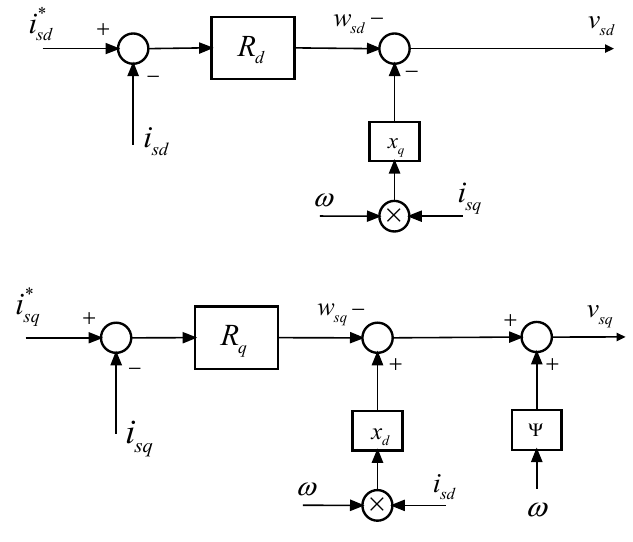
Figure 9. Current control loops.